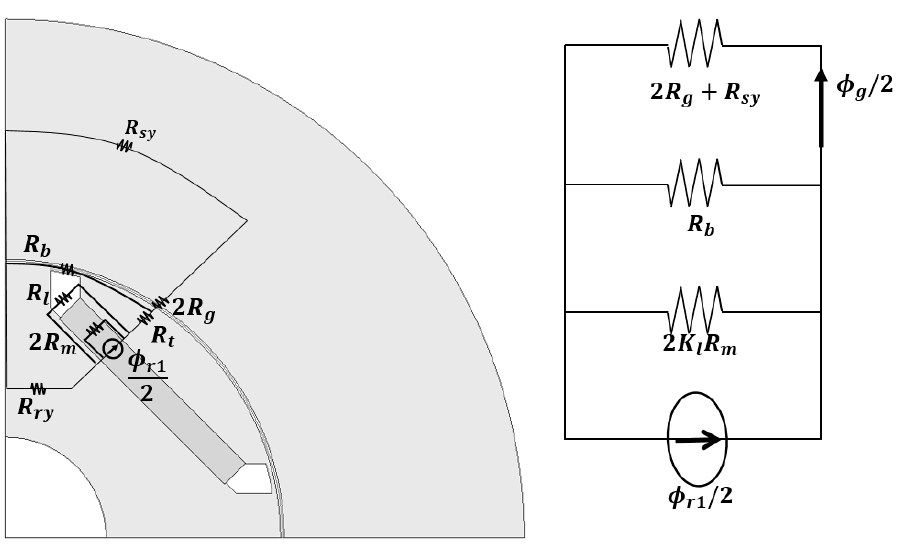
Figure 3. Magnetic circuit of a slotless permanent magnet.